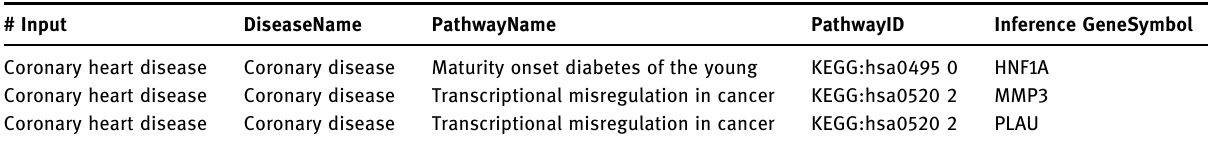
Table 3: Combining the pathways related to potential “ cis ” and “ trans ” genes identi fi ed with the KEGG analysis and related to CAD development in the CTD